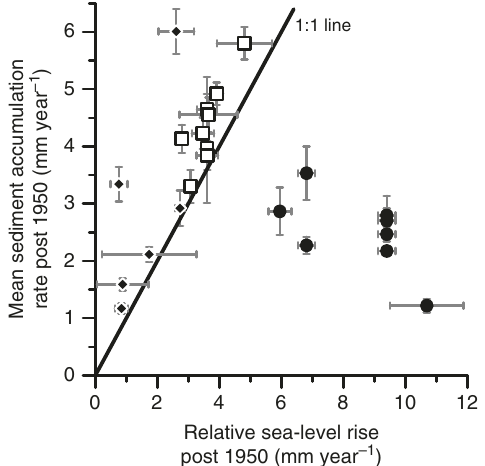
Fig. 6 Water depth stable or shallowing at sites excluding TX and